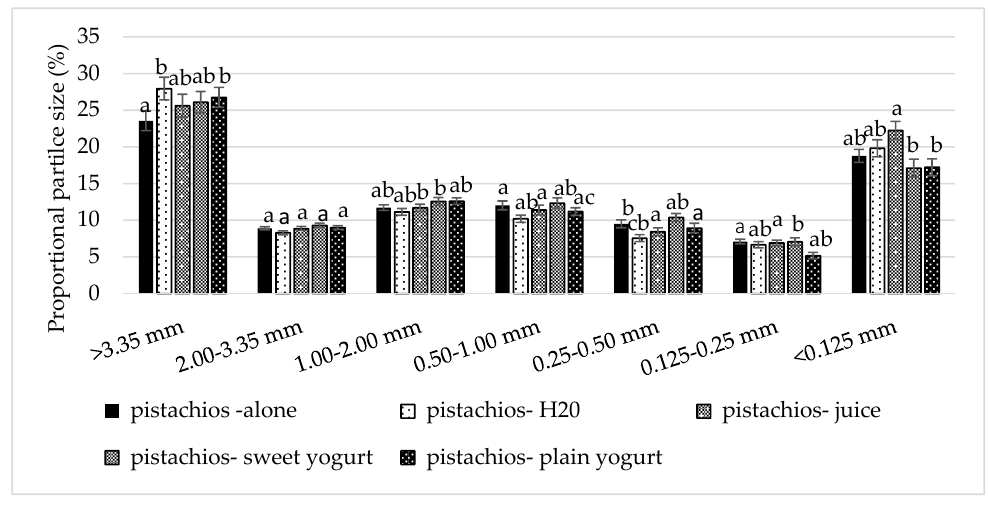
Figure 4. Mean ± S.E.M particle size distribution by condition for nuts: ( A ) walnuts, ( B ) almonds, and ( C ) pistachios. Comparisons are based on two-way repeated measures ANOVA with post hoc Bonferroni multiple comparison test. Different lower case letters denote significant differences between conditions ( p < 0.05).